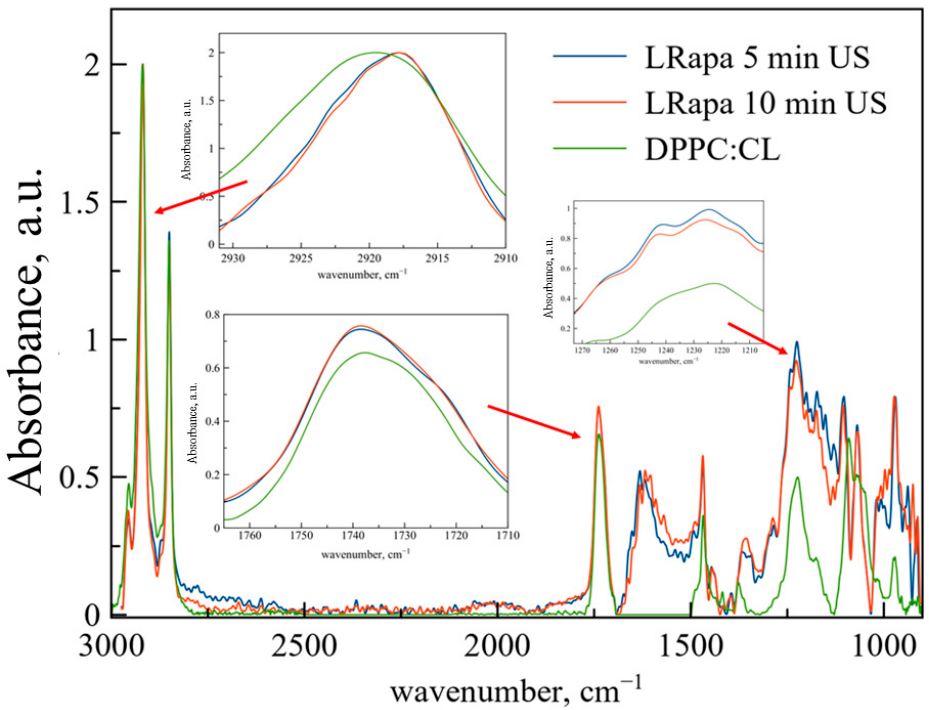
Figure 4. Normalized ATR-FTIR spectra of DPPC:CL 80:20 weight% liposomes and LRapa with 5 and 10 min of extra sonication. Total lipid concentration 5 mg/mL, 0.02 M sodium phosphate buffer solution pH 7.4, 22 ° C. Rapa spectra were subtracted as a background. Spectra of empty liposomes are green, spectra of LRapa are blue (5 min) and red (10 min). In the insets, areas of ν as (CH 2 ) , ν (CO) , ν as (PO 2 − ) are presented. Table 3. Position of the main absorption bands in the ATR-FTIR spectra of DPPC:CL 80:20 lipo-